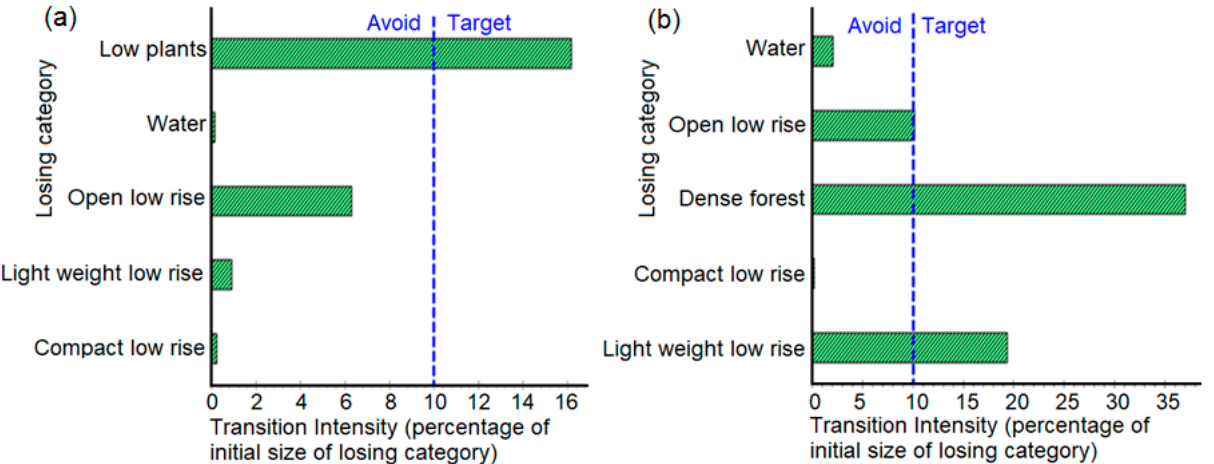
Figure 7. Transition intensity given ( a ) gain of dense forest from 1990 to 2005 and ( b ) low plants from 2005 to 2020.